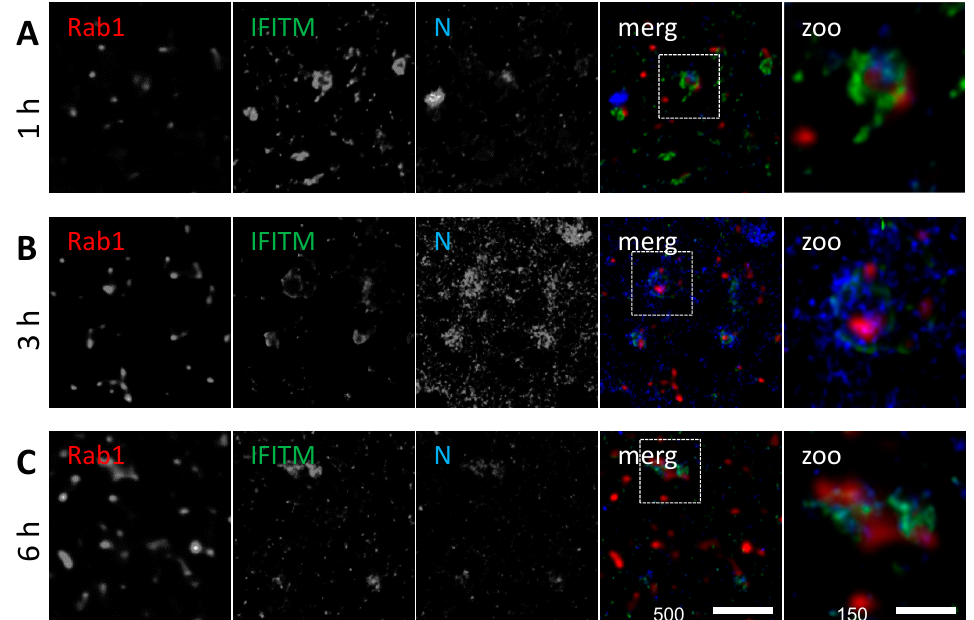
Figure 7. The co-localization of IFITM3 proteins with Rab11 and IAV NP. A549 cells were transiently transfected with pEGFP-C3_Rab11 (green) and infected with influenza A virus (IAV) A/Hong Kong/1/1968 (MOI = 1) 48 h after transfection. The cells were fixed with ice cold methanol at ( A ) 1 h p.i., ( B ) 3 h p.i., and ( C ) 6 h p.i., and subjected to an indirect immunofluorescence analysis using anti-IFITM3 (red) in combination with anti-NP (blue). The images show regions located in the cytosolic part, distant from the nucleus and absent from the plasma membrane. The image acquisition was performed using a 60 nm (= confocal mode, EGFP-Rab11) and 15 nm (= STED, IFITM3 and NP signal) pixel size. The dashed square indicates the zoom-in area.